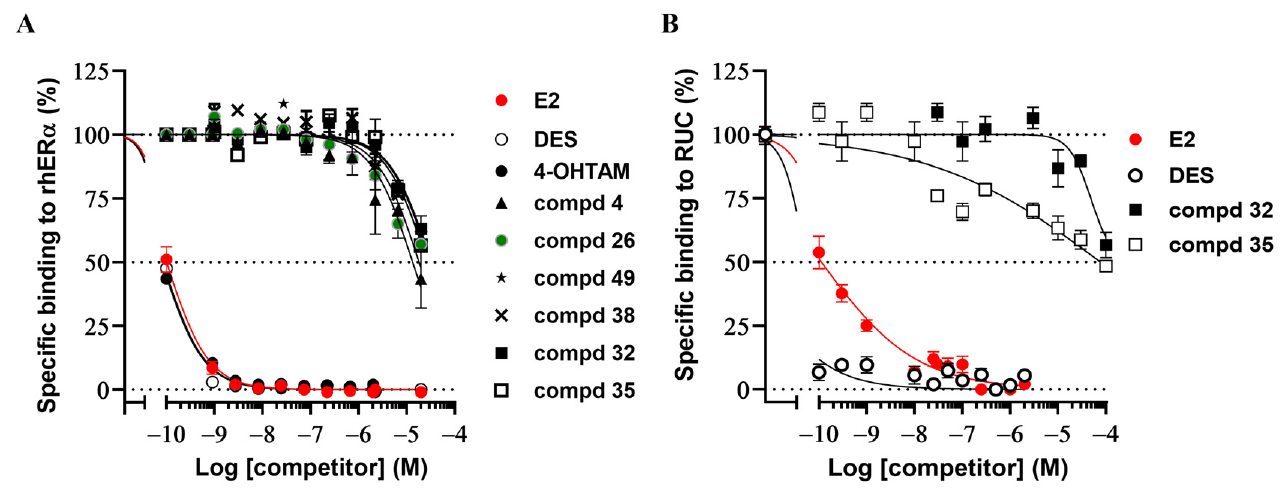
Figure 5. 5-Hydroxy-2 H -pyrrol-2-ones bind to rhER α and rat ER α with low affinity. ( A ) 5-Hydroxy- 2 H -pyrrol-2-ones 4 , 26 , 32 , 35 , 38 , 49 or control compounds (E2, DES or 4-OHTAM) competitors binding to rhER α was evaluated in 10-point titration competition curves (0.1 nM–20 µM) by using the LanthaScreen TR-FRET binding assay as described in Material and Methods. ( B ) The binding of competitors (compounds 32 , 35 , DES and E2) to native ER α was evaluated in 10-point titration com- petition curves (0.01 pM–100 µM) by using the radiolabeled E2 binding assay in rat uterine cytosol (RUC) as described in Material and Methods. Dotted lines are shown at 0 %, 50 % and 100 % of Specific binding to rhER α . Non-lineal regression analysis was performed by using data from two independent experiments in GraphPad Prism 8.4.3. Data are expressed as mean ± SEM for two in- dependent assays where each concentration was tested in duplicate.